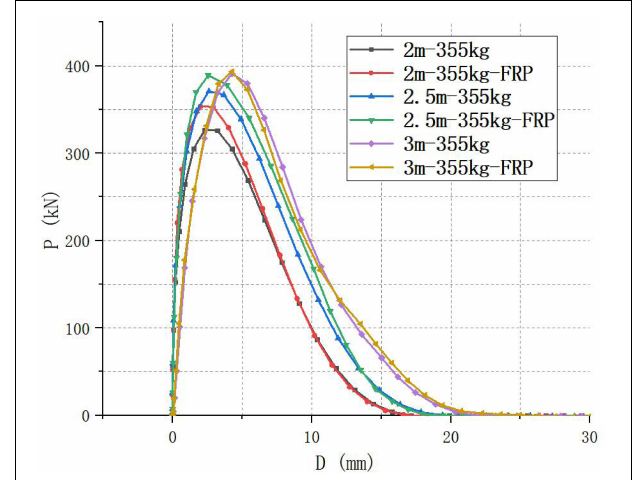
FIGURE 15 | Load-displacement